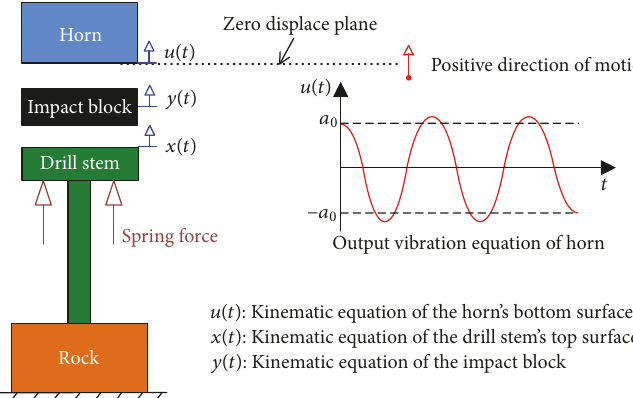
Figure 5: Sketch of the vibration-impact